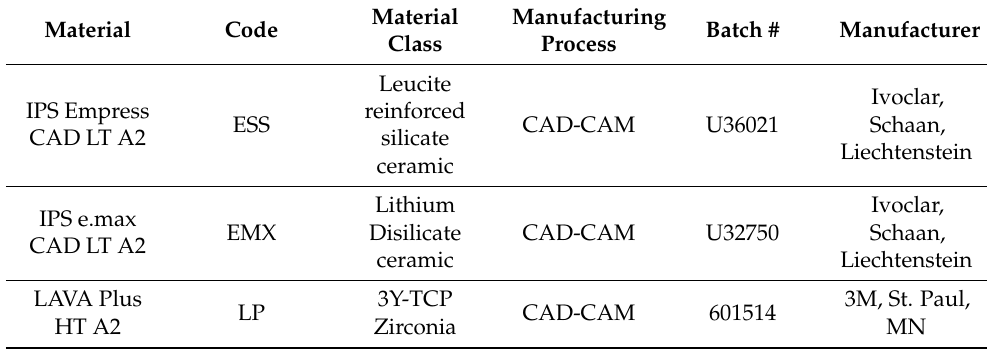
Table 1. Details of the dental ceramics